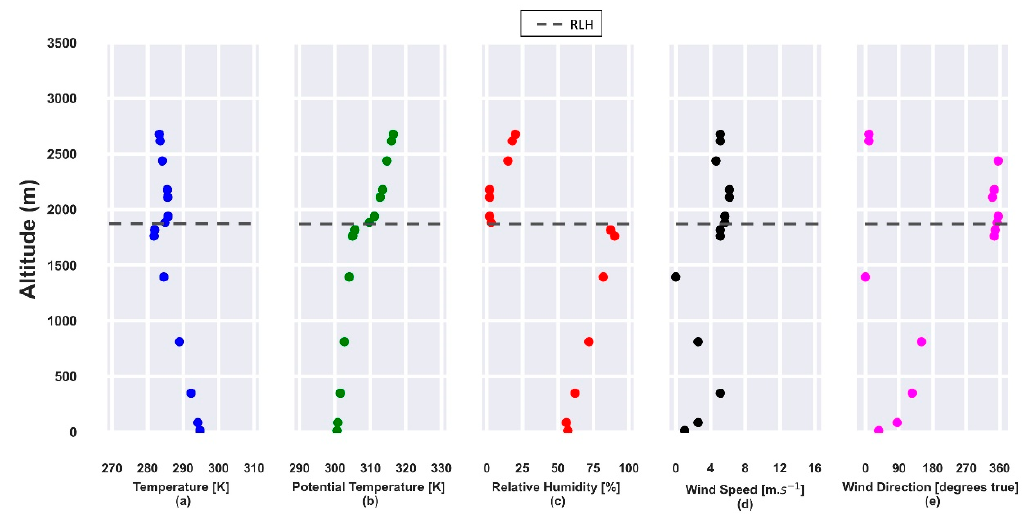
Figure 15. Atmospheric parameters obtained from radiosonde data on 25 July 2019, at 00:00 UTC. ( a ) Temperature [K]; ( b ) potential temperature [K]; ( c ) relative humidity [%]; ( d ) horizontal wind speed [m·s − 1 ]; ( e ) wind direction [degrees true]. The gray dashed line represents the RLH.